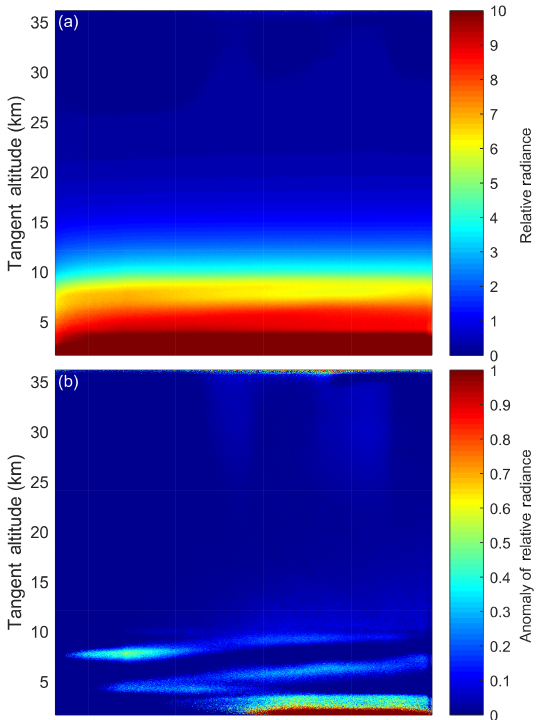
Figure 9. (a) Final calibrated 750nm image, taken at 13:57UTC, located at 48.55 ◦ N, 80.00 ◦ W with a solar zenith angle and solar scattering angle of 63 and 98 ◦ respectively. (b) The same 750nm image with the mean of the profile removed from the image leaving the residual signal that shows thin clouds in the